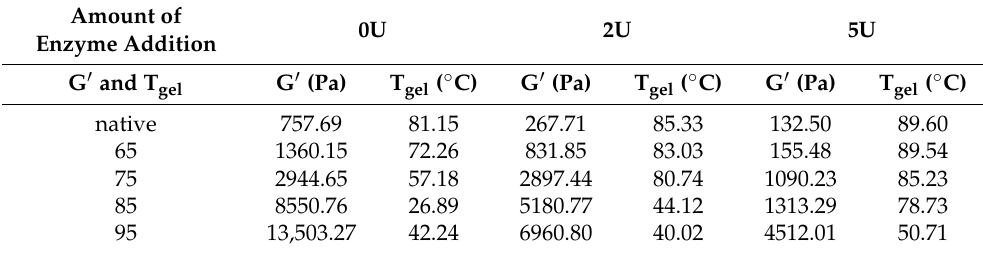
Table 1. The end-point elastic modulus (G (cid:48) ) of the gel and the gel temperature (T gel *). Amount